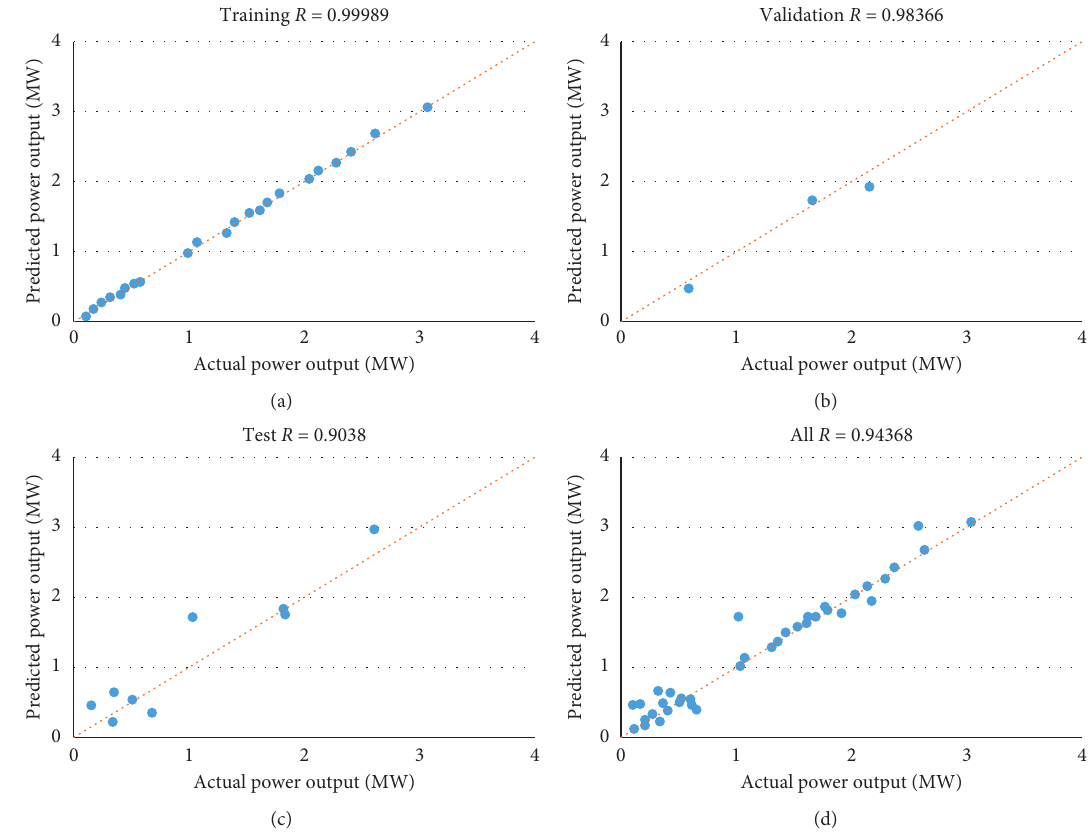
Figure 6: The predicted versus actual power for the LM algorithm at the validation percentage of 5%: (a) training, (b) validation, (c) test, and (d)